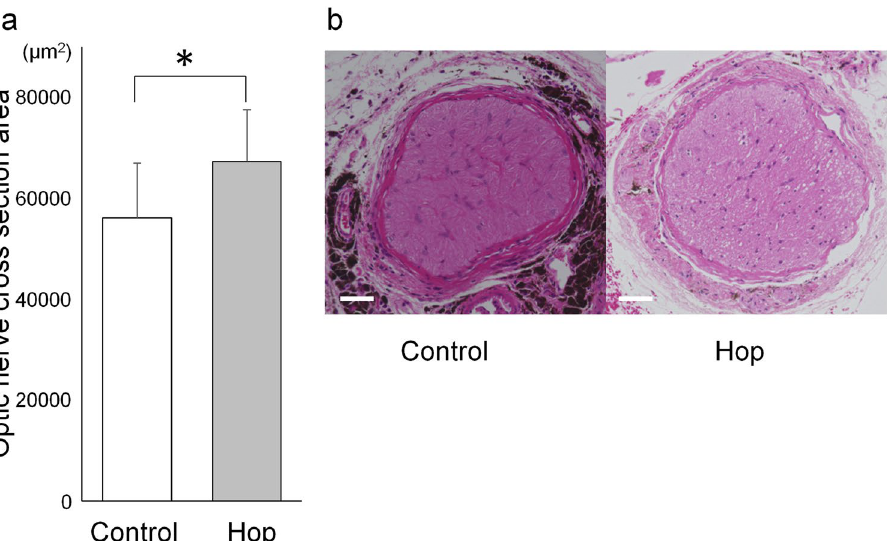
Figure 4. Prevention of optic nerve thinning in GLAST (+/−) mice administered with hop extracts. ( a ) Optic nerve cross section area of 18-month-old GLAST (+/−):Thy1-CFP mice administered with hop extracts or water as a control. *p ≤ 0.05, unpaired t -test, n = 6 and 8 eyes in the hop-treated and control groups, respectively. ( b ) Images of the optic nerve cross sections of 18-month-old GLAST (+/−):Thy1-CFP mice administered with hop extracts or water as a control, indicating the median areas. Bars represent 50